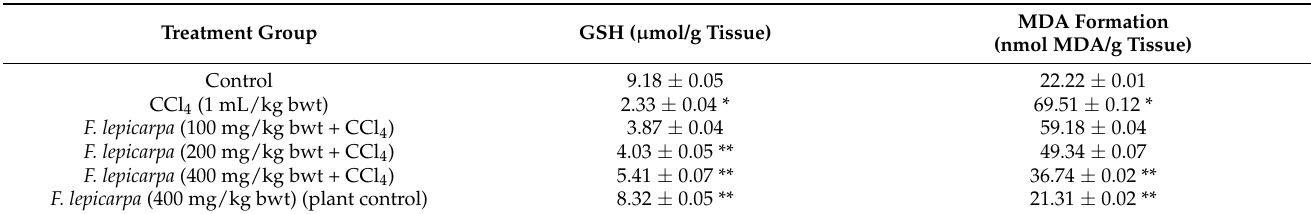
Table 5. Effects of F. lepicarpa on hepatic GSH and MDA levels following CCl 4